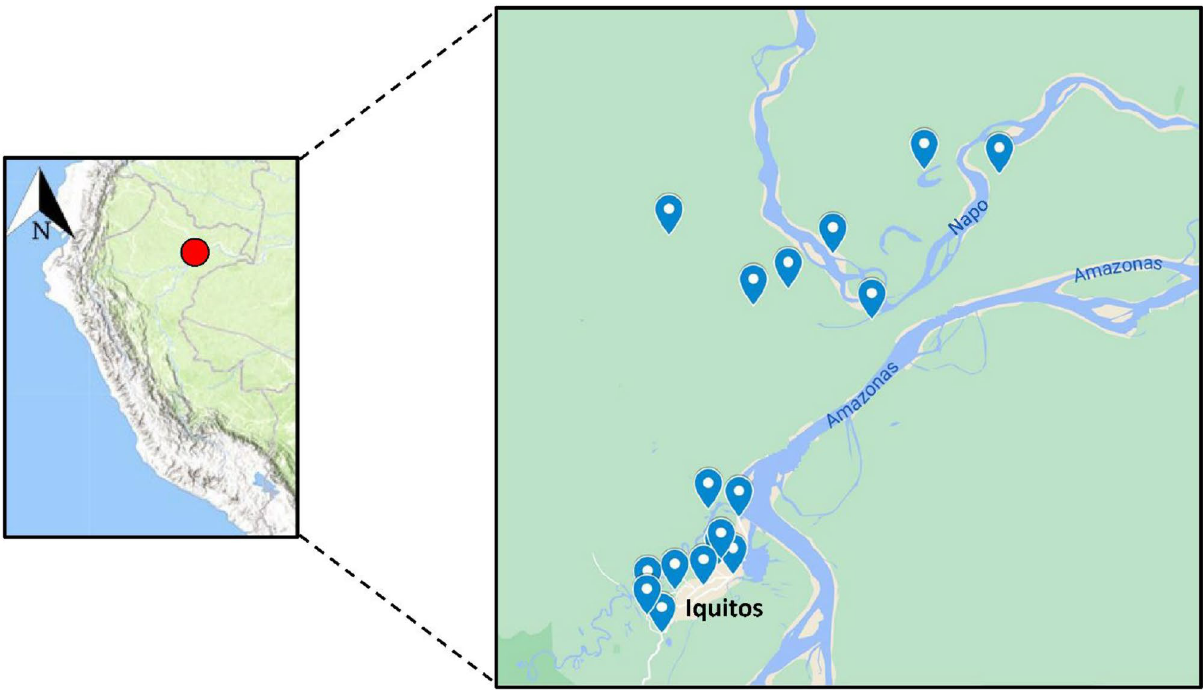
Figure 1. Map of the study sites located in the region of Loreto. The inset shows the location of the field sites in and around Iquitos city depicted in blue marks. The map was created using ArcGIS online (ESRI Inc. Redlands, CA, USA. https:// www. esri. com/) using open data obtained from GADM database of Global Administrative Areas, version 3.6. www. gadm.